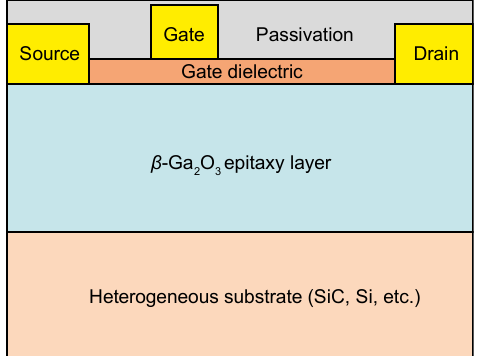
Figure 10. Device diagram of β -Ga 2 O 3 FET fabricated on a heterogeneous substrate. More aggressive heat dissipation engineering is required for β -(Al x Ga 1 − x ) 2 O 3 / β -Ga 2 O 3 HEMT since β -(Al x Ga 1 − x ) 2 O 3 exhibits even lower thermal conductivity